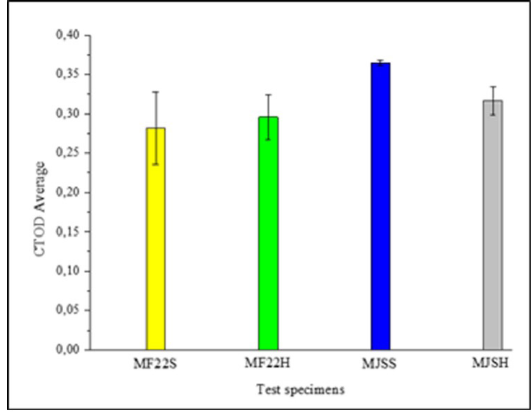
Figure 22. Average and standard deviation of CTOD results (δ) for the four conditions